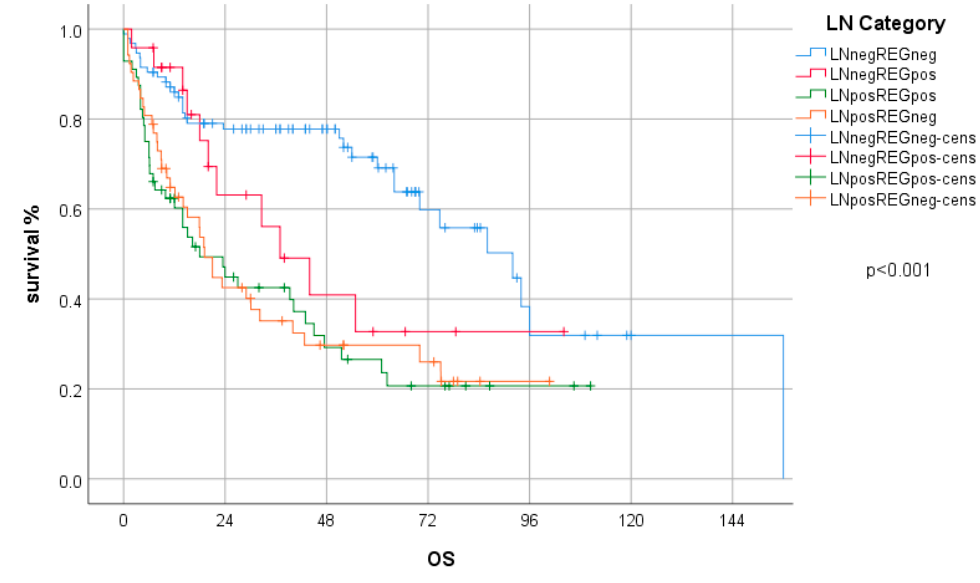
Figure 1. LN categories and overall survival (OS).